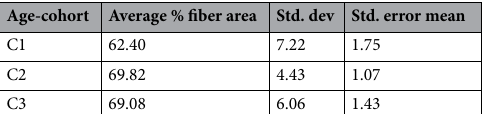
Table 5. Average percent fiber area, standard deviation and standard error for each muscle for a subset of each age-cohort (C1 = 3 weeks old; C2 = 8 months old; C3 = 2 years old) and the connecting letter report from a Tukey’s HSD test comparing the three